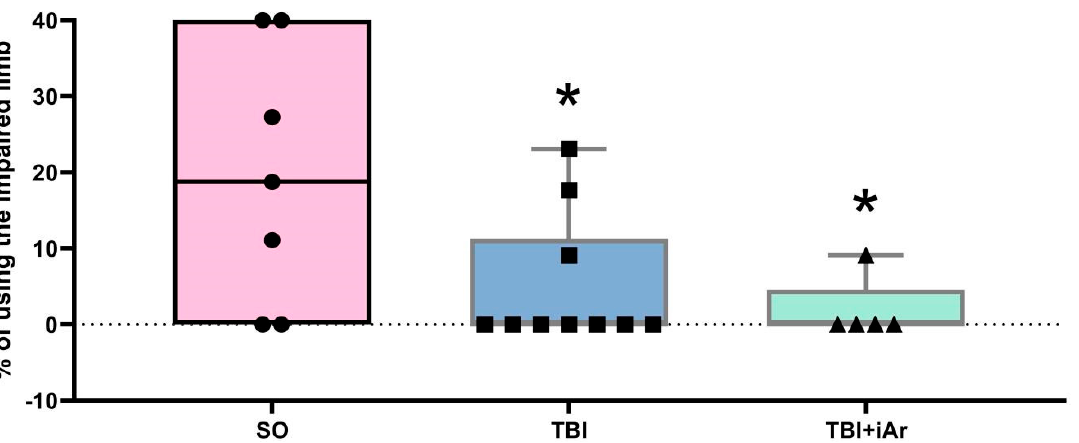
Figure 3. The cylinder test results. Day 13 day after the traumatic brain injury. The data are pre-